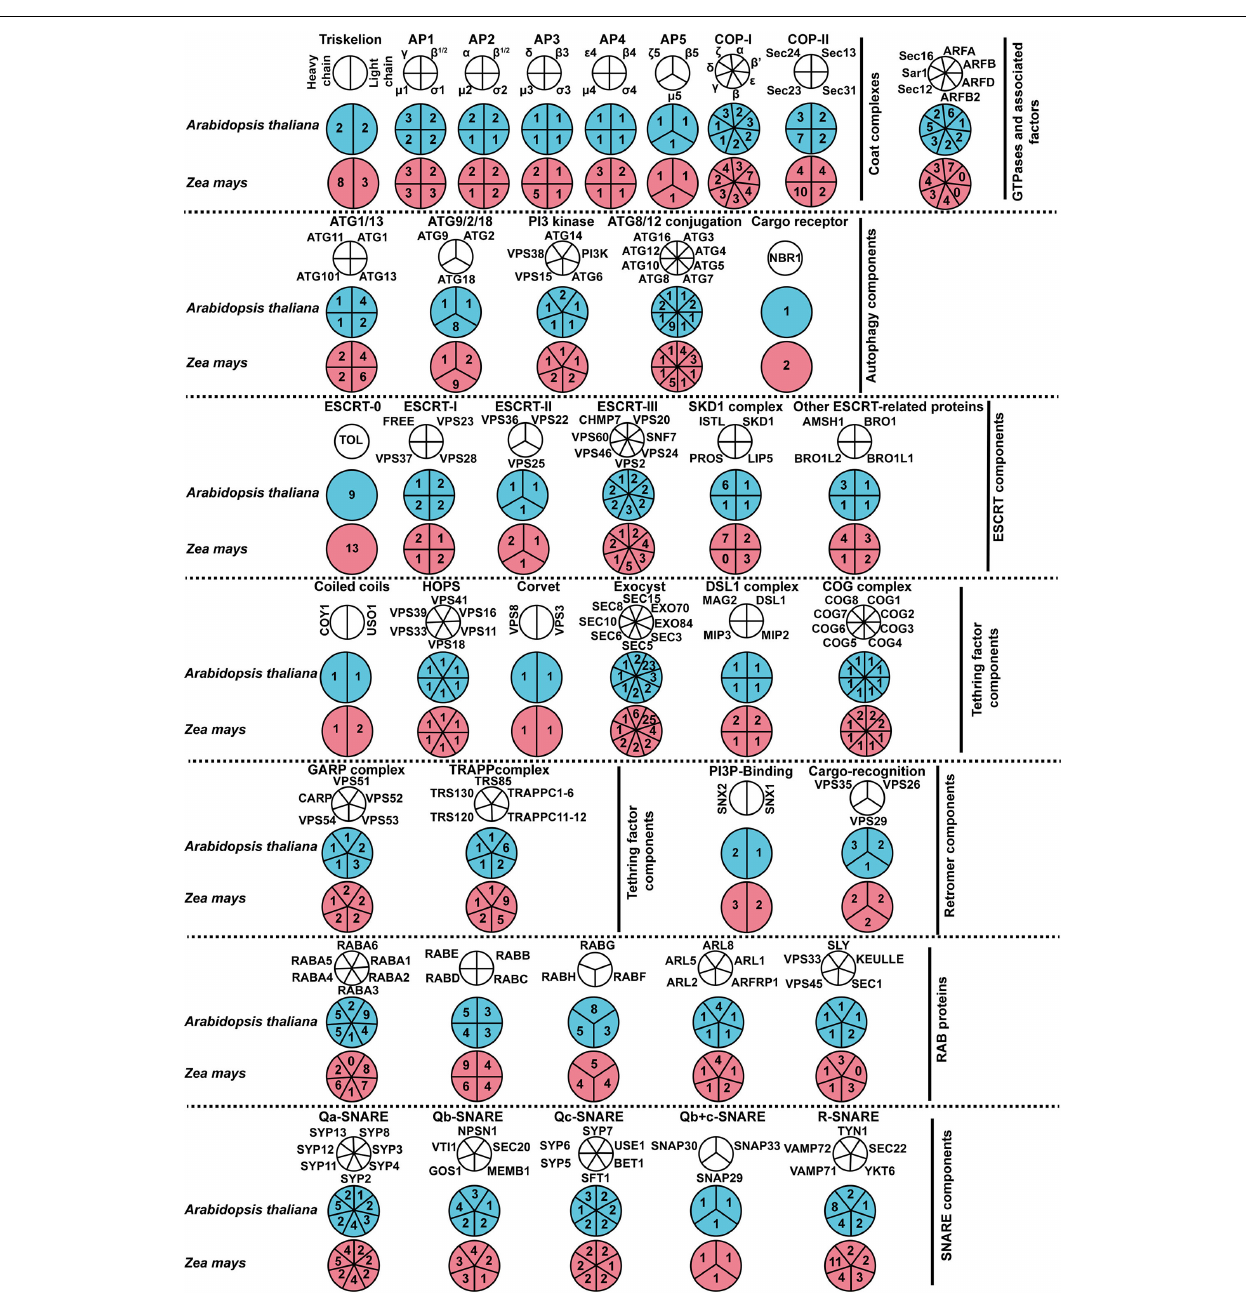
FIGURE 1 | An overview of endomembrane-trafficking components in Arabidopsis thaliana and Zea mays . Coulson plot depicting components of coat complexes, autophagy machinery, ESCRT machinery, tethering factors, retromer proteins, Rab proteins, and SNARE proteins in A. thaliana and Z. mays . Legends at the top of each column refer to the subunits of complexes. Numbers indicate relevant paralog counts. Homologs of these factors were identified and listed in Supplementary Datasets 1–7